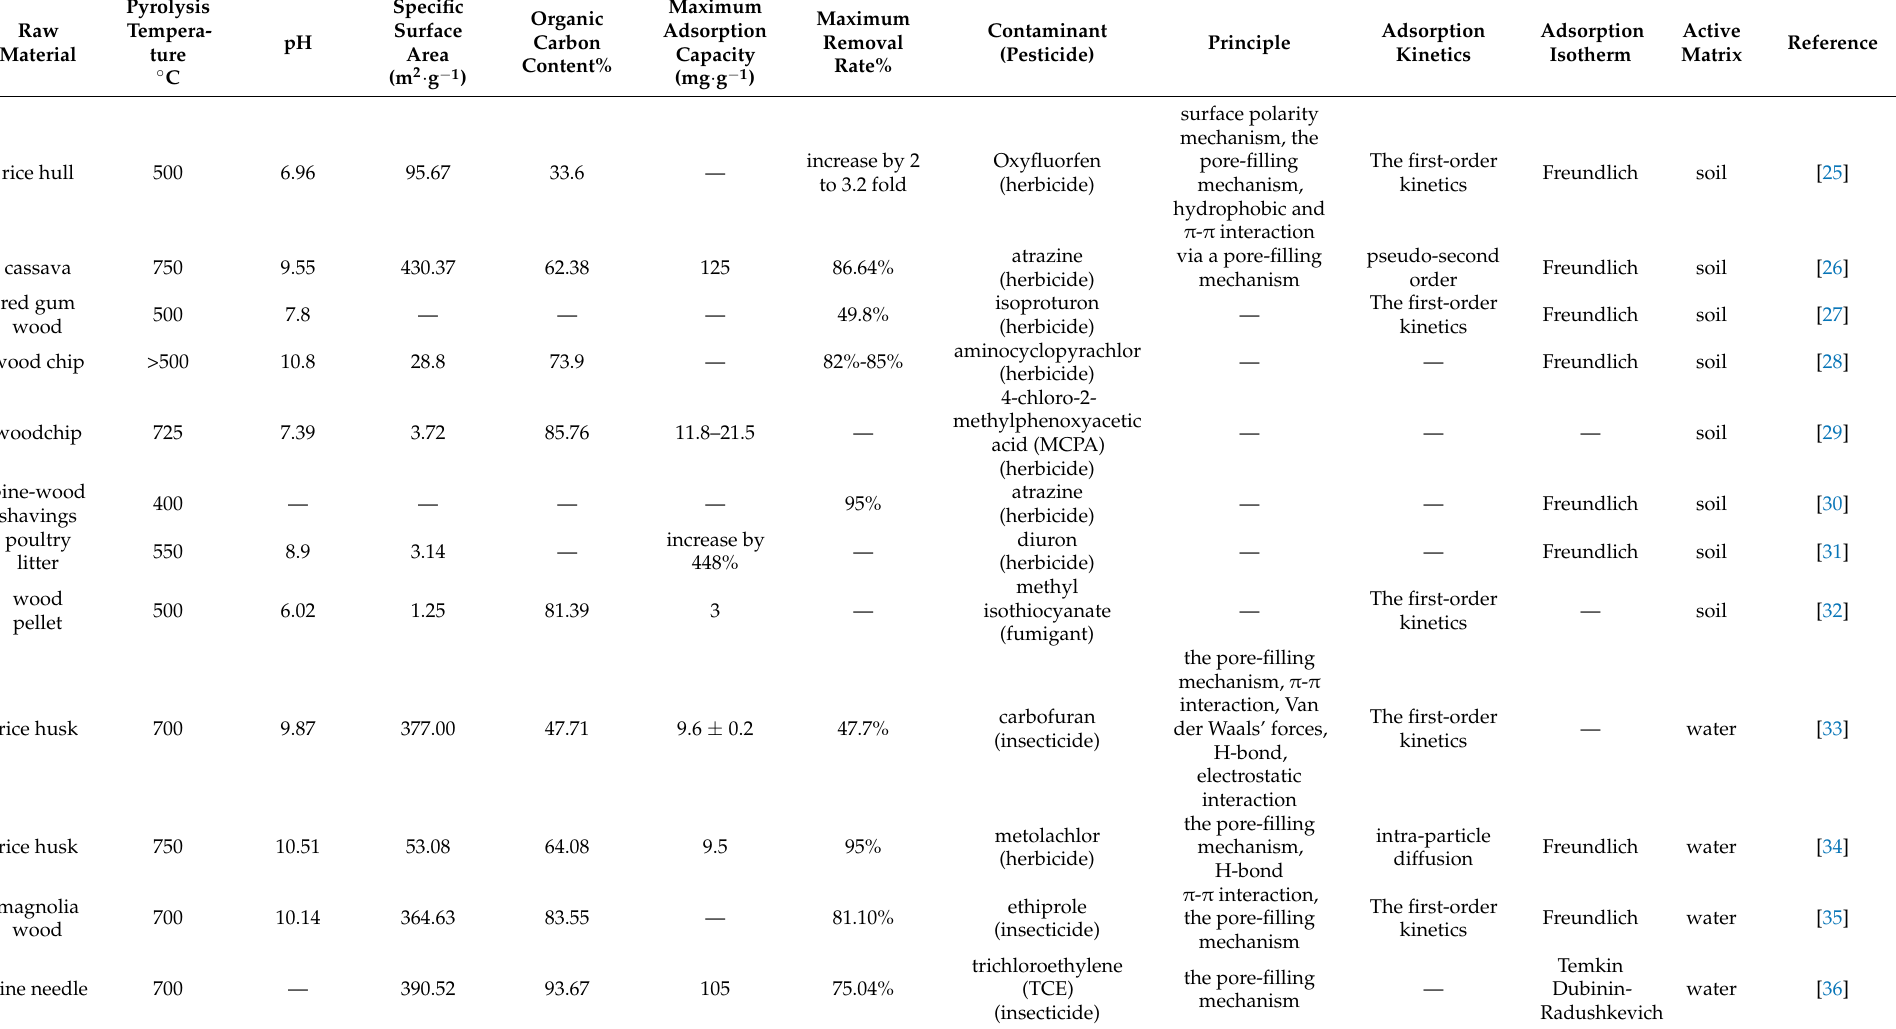
Table 1. Effect of biochar source on adsorption capacity and removal